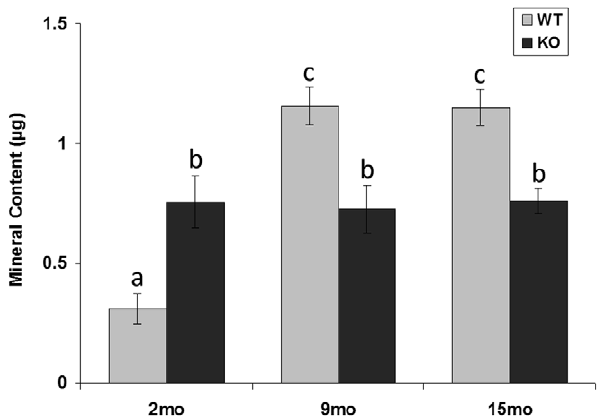
Figure 4. Mineral content of the Col6a1 2 / 2 tibial metaphysis. In the tibial metaphysis directly distal to the fibular attachment (25 microCT slices=0.4 mm), wild-type mice quadrupled their mineral content from 2-months-old to 9-months-old. In contrast, collagen VI null mice already had an intermediate level of mineral content by 2 months of age; this mineral content never changed. Bars are mean 6 SEM; those sharing the same letter are not statistically different; bars with different letters: p , 0.01. WT= Col6a1 + / + ; KO= Col6a1 2 / 2